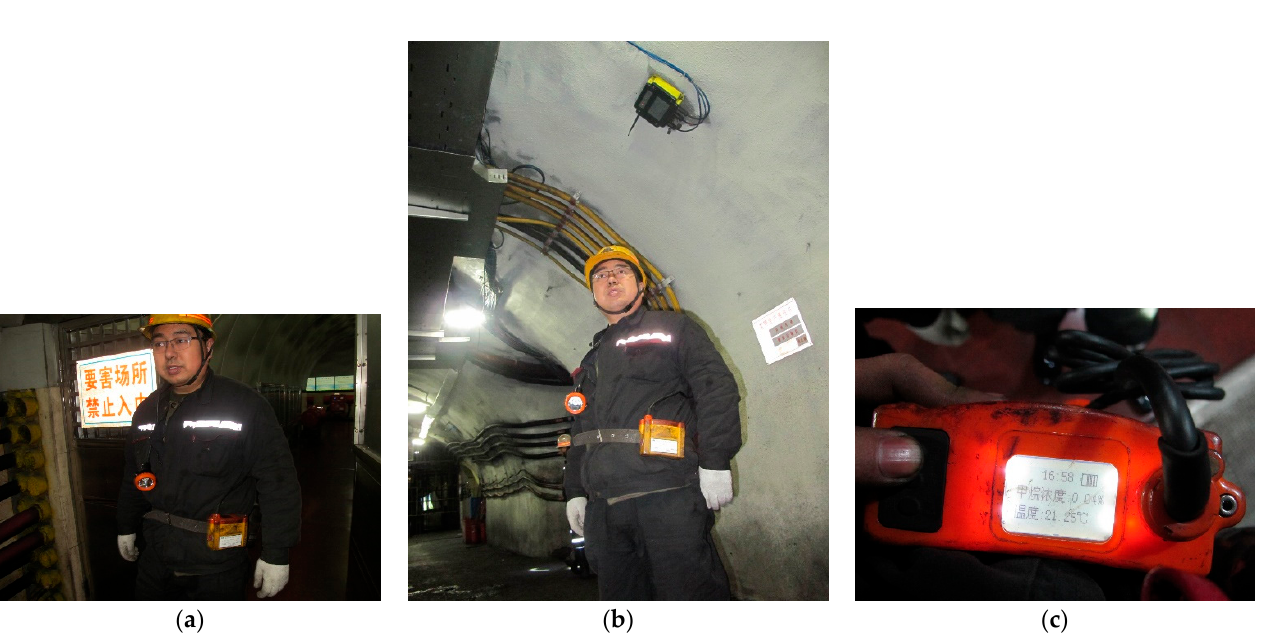
Figure 3. Network model of monitoring system. ( a ) Miner and smart miner’s lamp, ( b ) fixed gas sensor and wireless access point, ( c ) gas monitoring data.